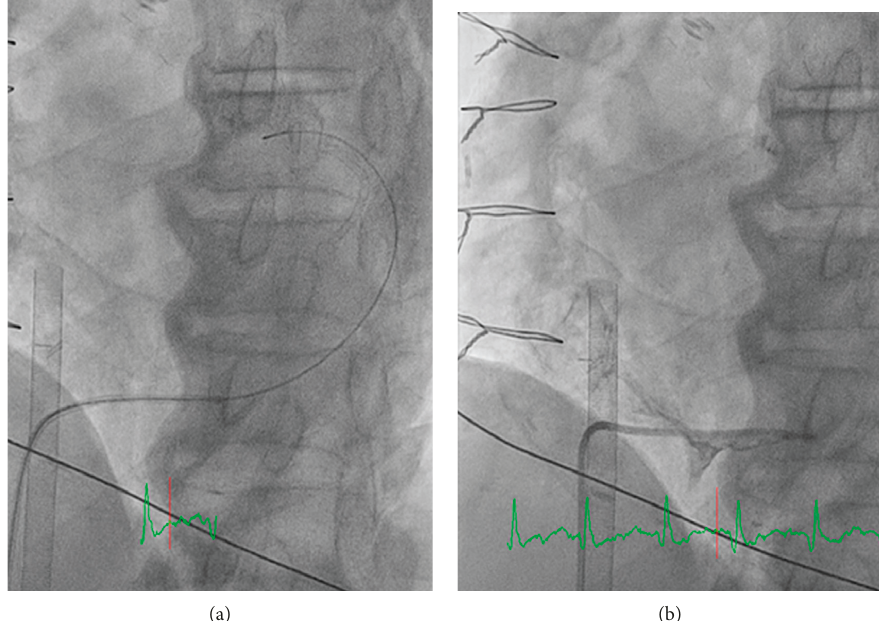
Figure 4: (a) Cannulation of the coronary sinus with an AL-1 catheter and hydrophilic wire. (b) Contrast injection through the AL-1 catheter showing compression and no flow of the coronary sinus.